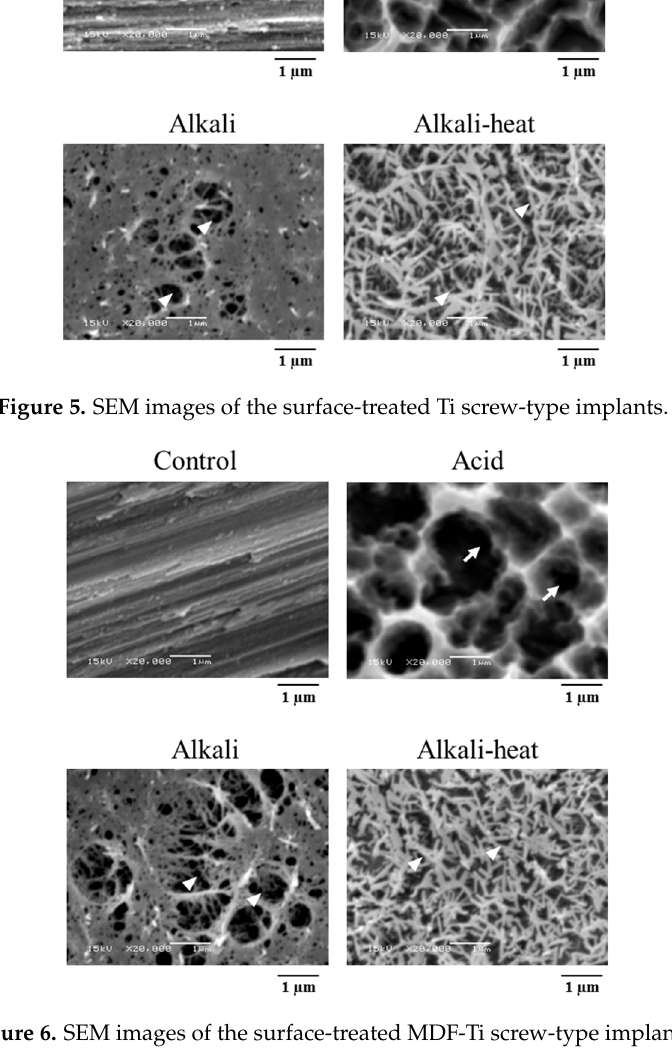
Table 2. Three-dimensional arithmetic mean height (Sa) of surface-treated implants (µm).